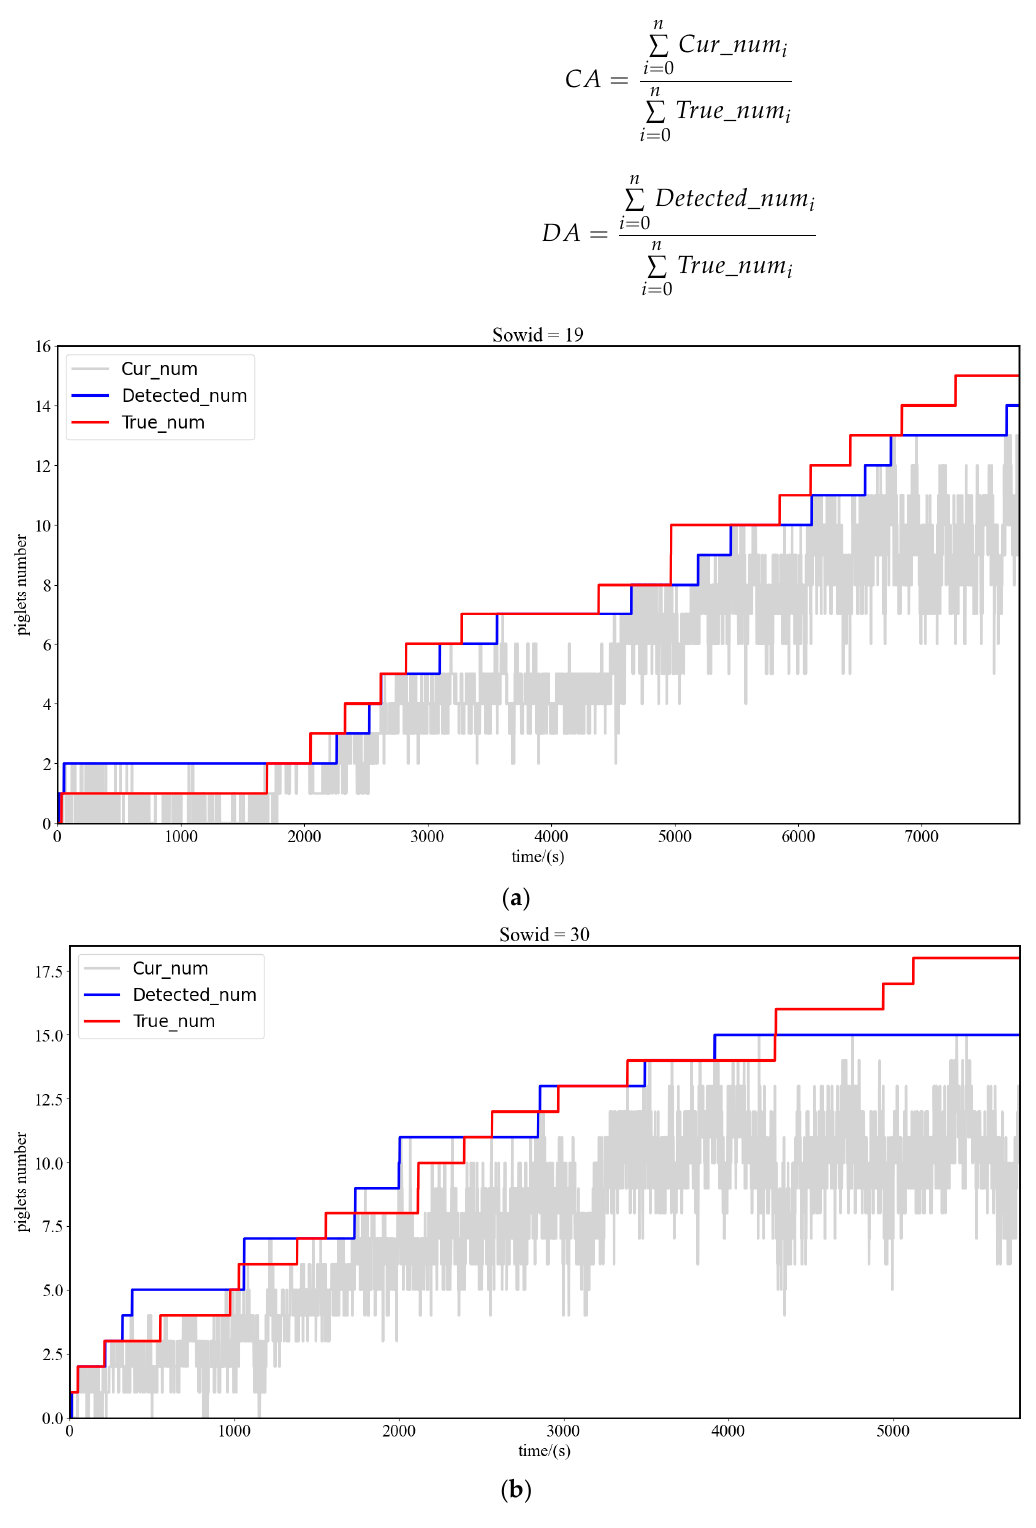
Figure 14. Test results for the number of piglets (two sows are taken for example). ( a ) Test results for the number of piglets (Sowid = 19), ( b ) Test results for the number of piglets (Sowid = 30). Table 4. Results of the number of piglets detected per pen.